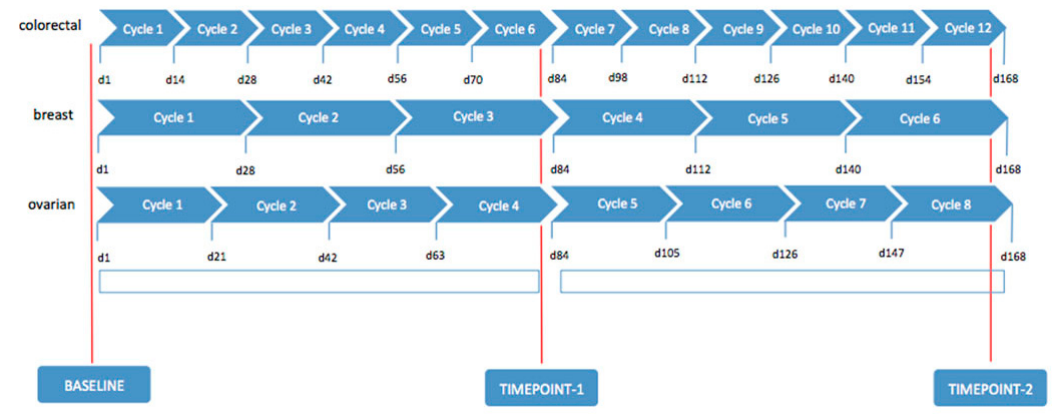
Figure 1. Treatment schedule and evaluation timing for colorectal, breast, and ovarian cancer patients respectively.